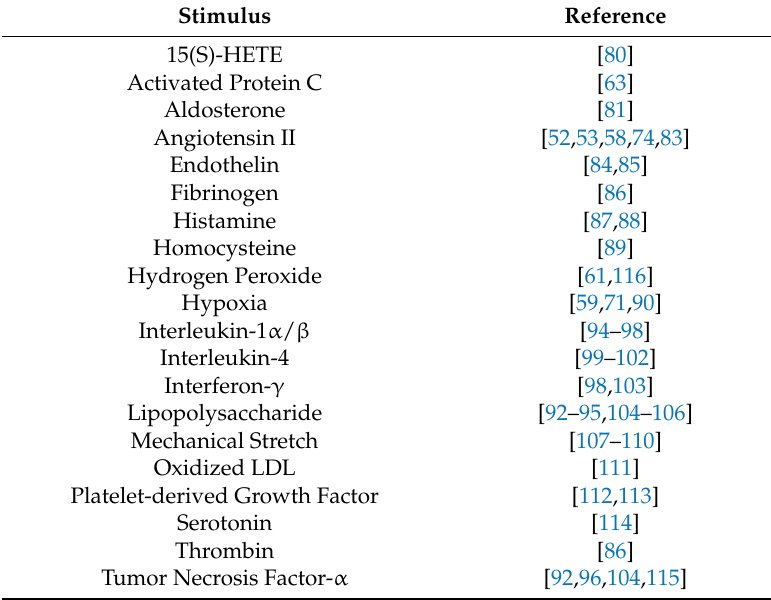
Table 1. Stimuli that increase IL-6 expression in vascular